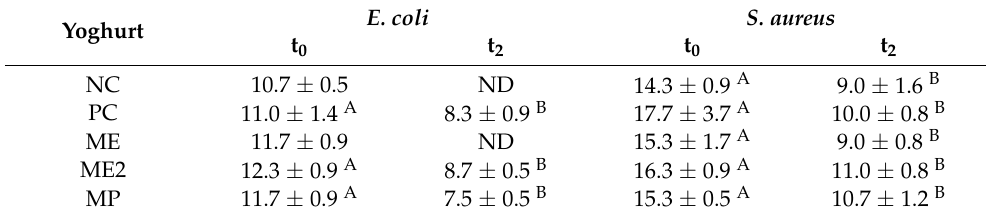
Table 6. Antibacterial activity of the yoghurts, for t 0 and t 2 , against E. coli and S. aureus . E. coli S. Yoghurt